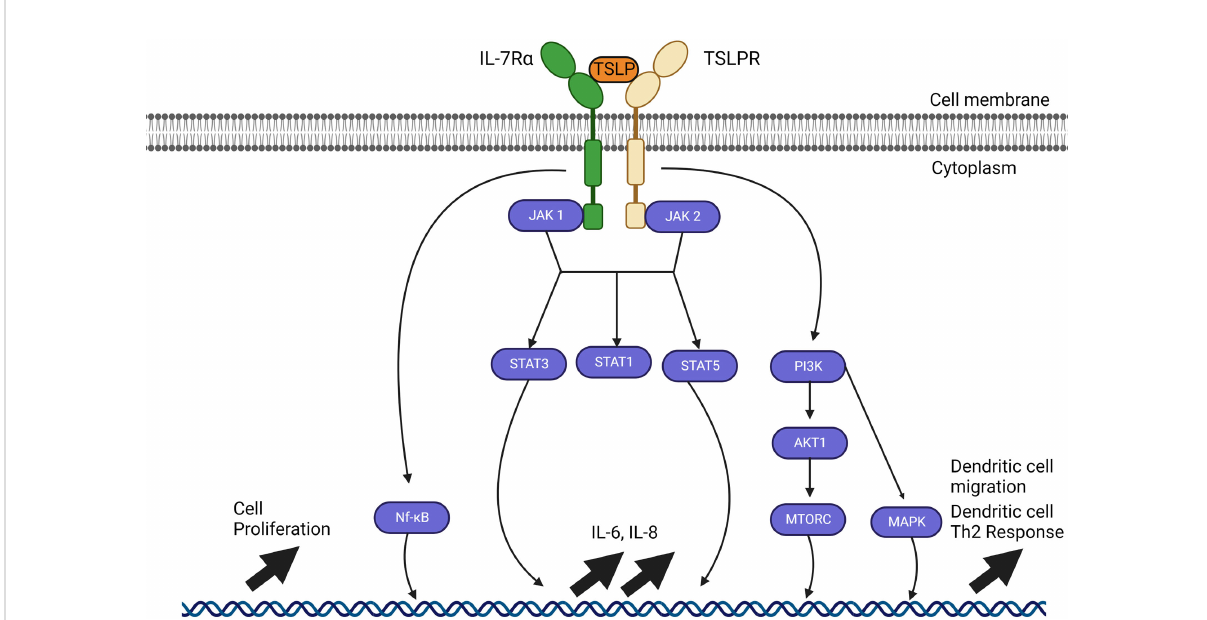
FIGURE 2 TSLP signalling pathways through JAK1 and JAK2. TSLP signaling pathways require a heterodimer of IL-7Ra and TSLP receptor (TSLPR). Interaction between TSLP and its receptor cascades in a signaling pathway through JAK1 and JAK2 which varies depending on the cell type. JAK1 and JAK 2 can activate STAT1, STAT3 and STAT5 as well as NF-kB and MAP kinases through PI3K, but all these pathways have not been fully resolved. The outcome of activation also varies with the type of cell affected, but includes upregulation of IL-6, IL-8, cell proliferation; in dendritic cells, activation by TSLP causes their migration and maturation to a Th2